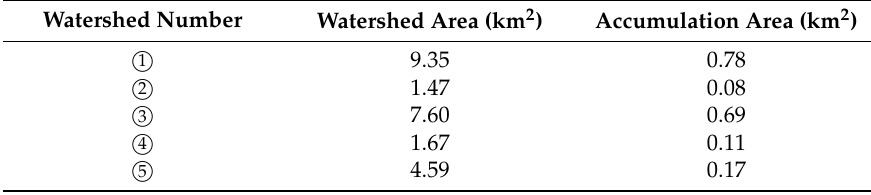
Table 1. Watershed area and accumulation area of different debris flows.